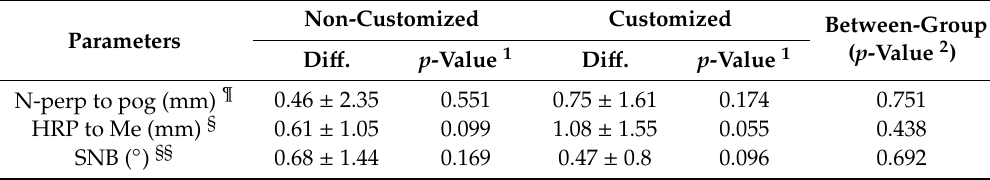
Table 6. Comparison of skeletal changes between the two groups (T2 vs. T1). Parameters